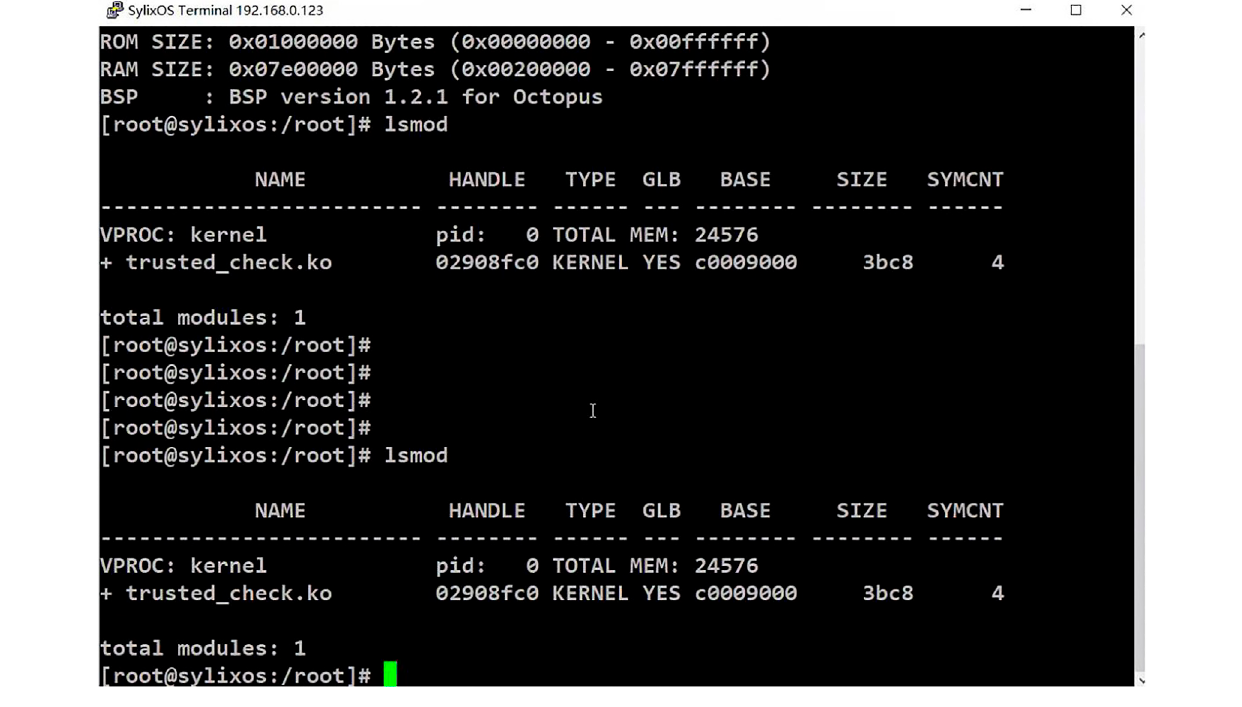
FIGURE 7 | Trusted_check.ko.